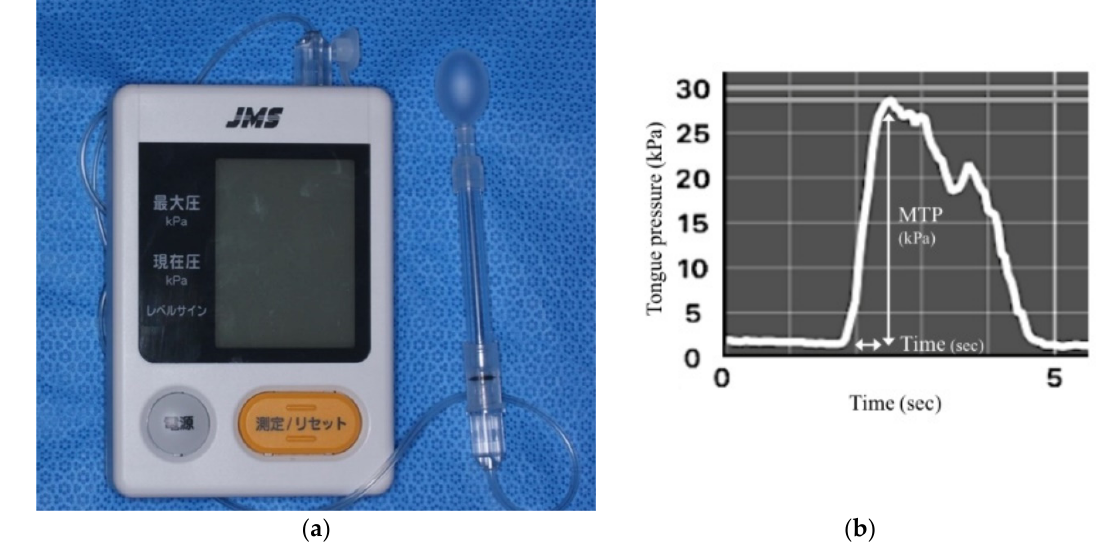
Figure 1. Tongue pressure measurement and assessment. ( a ) Tongue pressure measuring instrument. Tongue pressure was measured using the JMS tongue pressure measuring instrument (TPM-01, JMS, Hiroshima, Japan). The instrument has a power button and a measurement start button, and the LCD monitor displays the maximum tongue pressure and the current pressure value. ( b ) Rate of